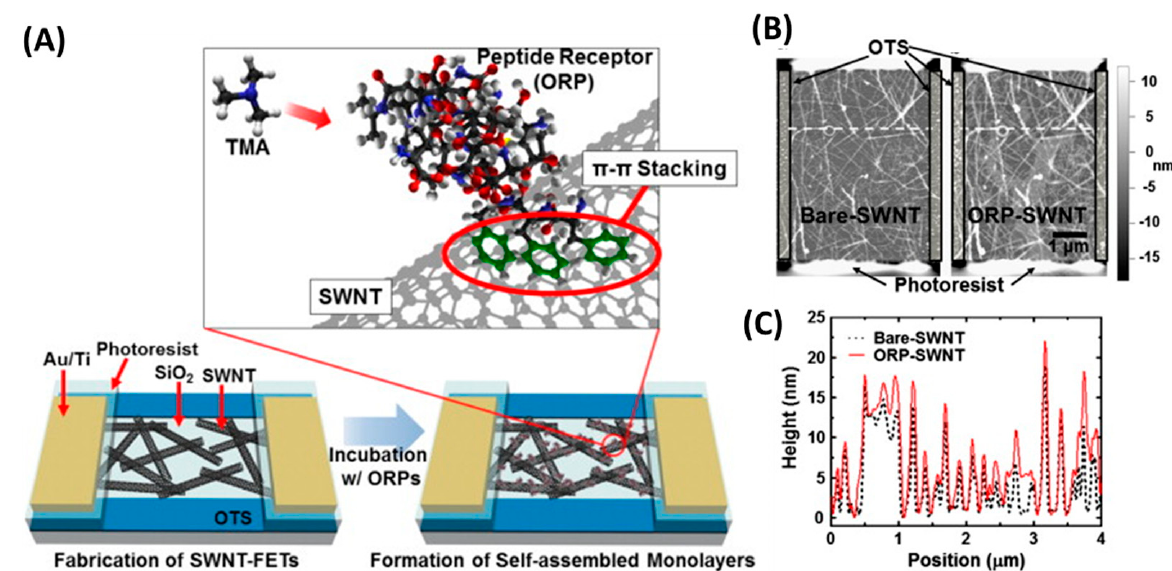
Figure 17. The electronic nose for the detection of TMA. ( A ) ORPs were self-assembled on the surface of SWNTs during the treatment of ORP-suspended deionized water solutions. The ORPs were immobilized by π – π stacking of aromatic rings at their C-terminus and attracted TMA molecules very near to the SWNTs. ( B ) Atomic force microscopy images of bare and ORP-immobilized SWNT channels on the fabricated sensor devices. ( C ) Height profiles of specific cross sections (white dashed lines in ( B )). The height of SWNTs increased by 2–3 nm after immobilization of the ORPs. [162]. Copyright 2013, Elsevier.